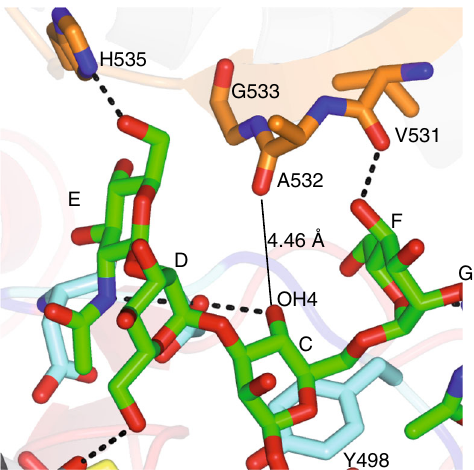
Fig. 6 The bisecting GlcNAc in N -glycans. N -glycans carrying a bisecting GlcNAc are not substrates of Hs FUT8 likely due to a steric clash between